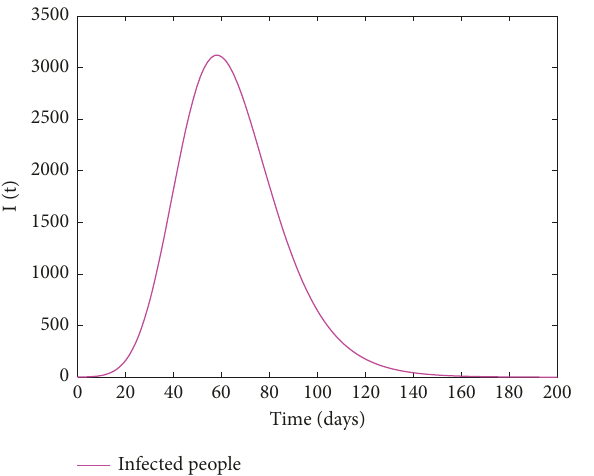
Figure 9: Behaviour of the individuals removed from